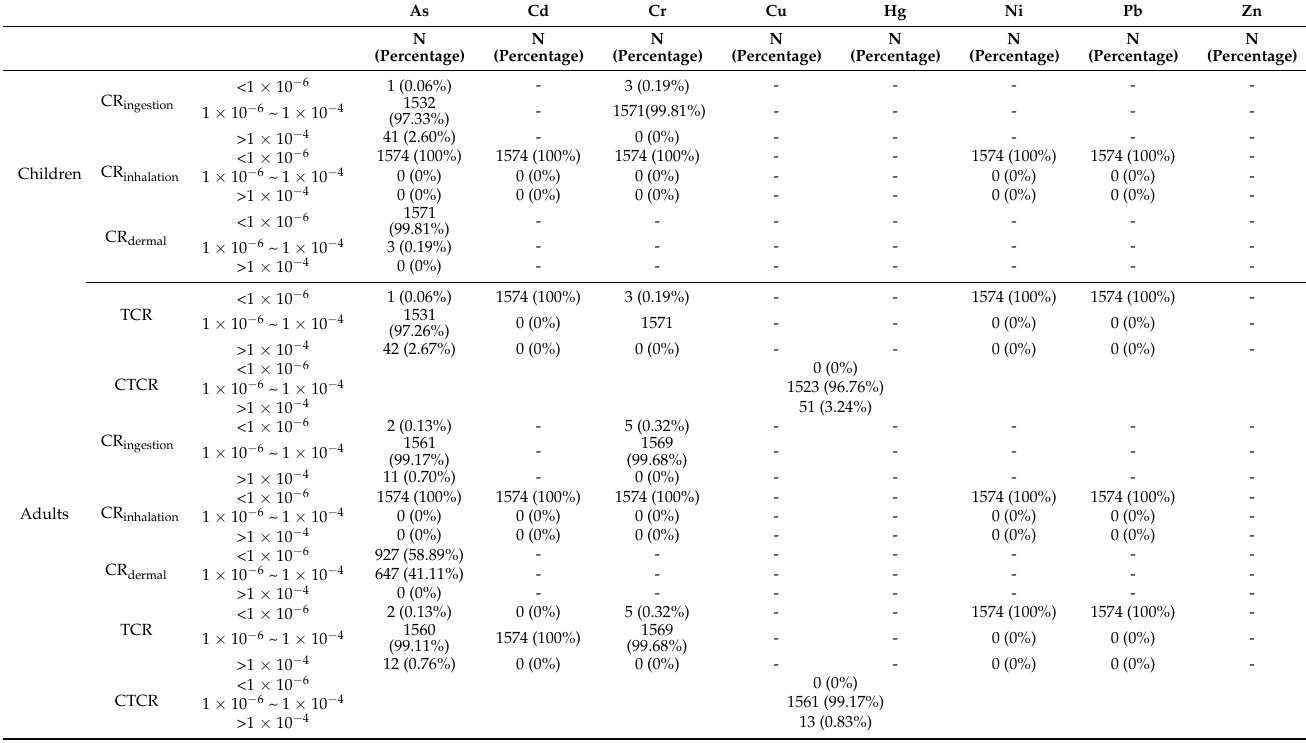
Table 9. The sites number of sites (percentage) of carcinogenic risk levels to humans from soil